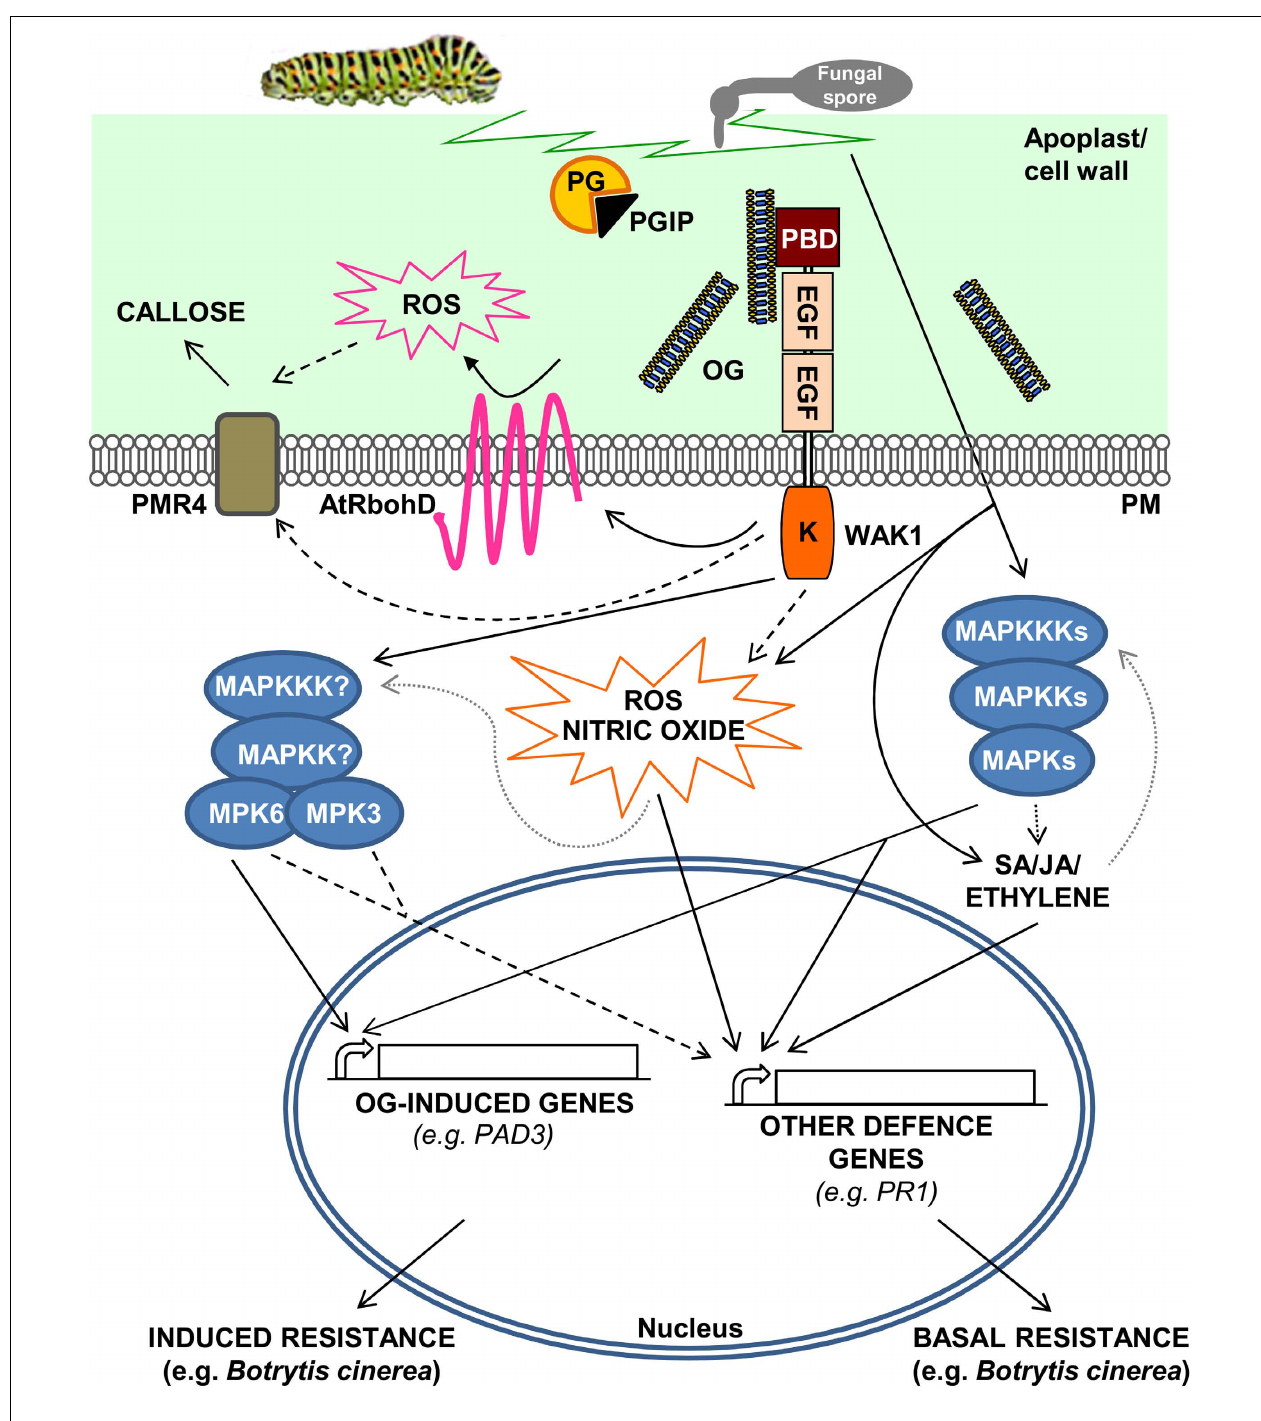
FIGURE 1 |A model for the activation of Arabidopsis thaliana defense responses triggered by oligogalacturonides (OGs). OGs are released from the cell wall after degradation of homogalacturonan by mechanical damage or by the action of hydrolytic enzymes such as PGs, secreted by pathogens. PGIPs in the apoplast modulate PG activity, favoring the accumulation of elicitor-active OGs, which function as DAMPs. OGs are perceived byWAK1 and trigger defense responses such as ROS accumulation through the activation of the NADPH oxidase AtRbohD, nitric oxide production, callose deposition, and MAPK-mediated activation of defense